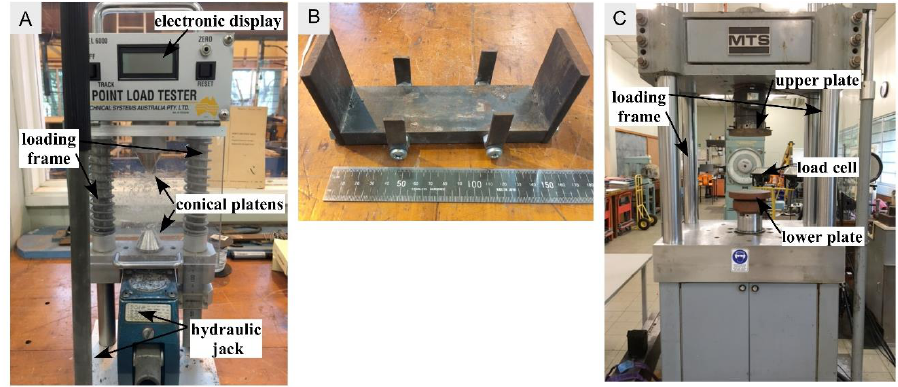
Figure 3. ( A ) Photograph of the portable point load tester used for the point load tests. ( B ) Photograph of the jig used to hold the samples in place for the indirect tensile strength (ITS) test. ( C ) Photograph of the MTS machine used for the UCS tests. All testing equipment is located in the engineering laboratory at James Cook University,